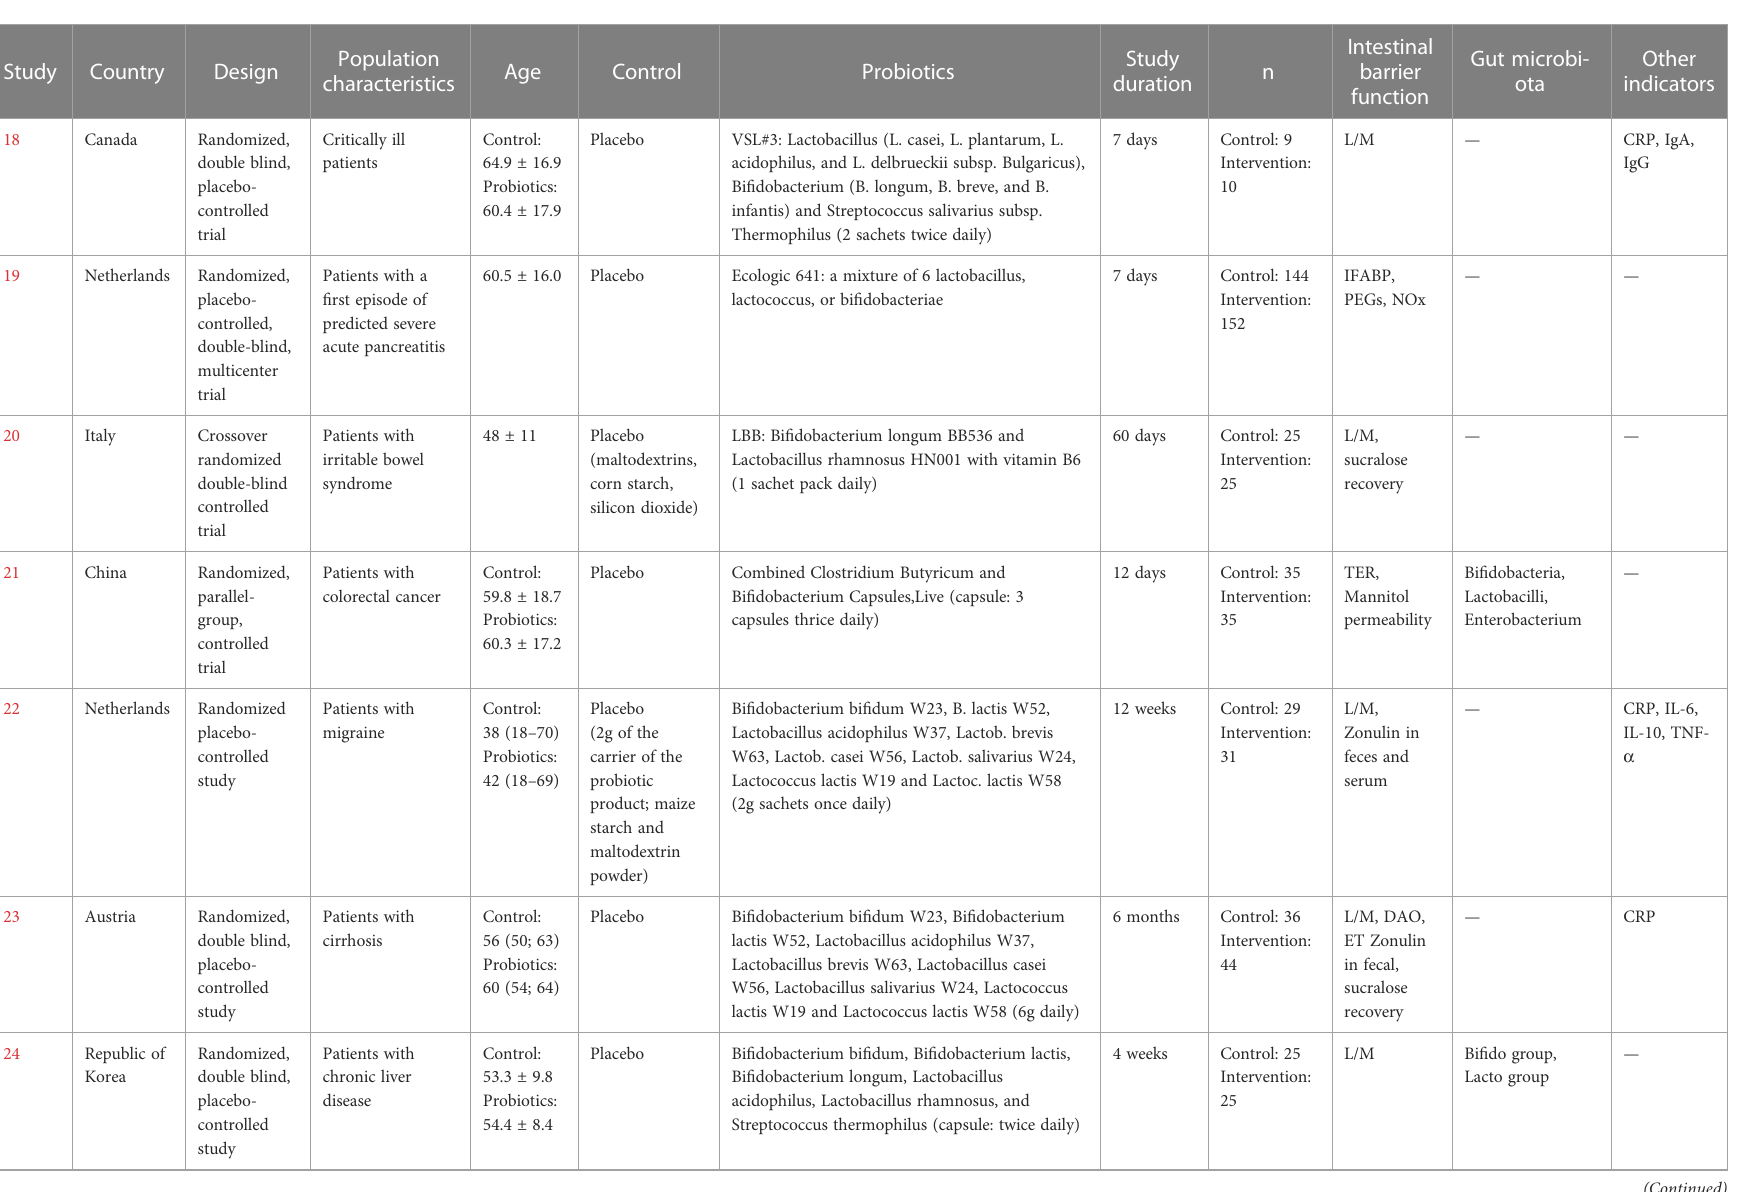
TABLE 1 Characteristics of included randomized controlled